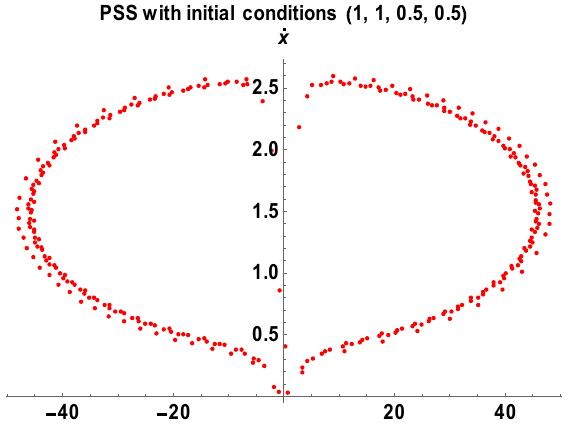
Figure 14. The PSS for the Earth–Moon system with µ = 0.01215, A = 0.0000003686, e = 0.0549, a = 1.000453, T = 0.01, σ 1 = 0.15, σ 2 = 0.003, α = 0.015, k = 3, M b = 0.03 .